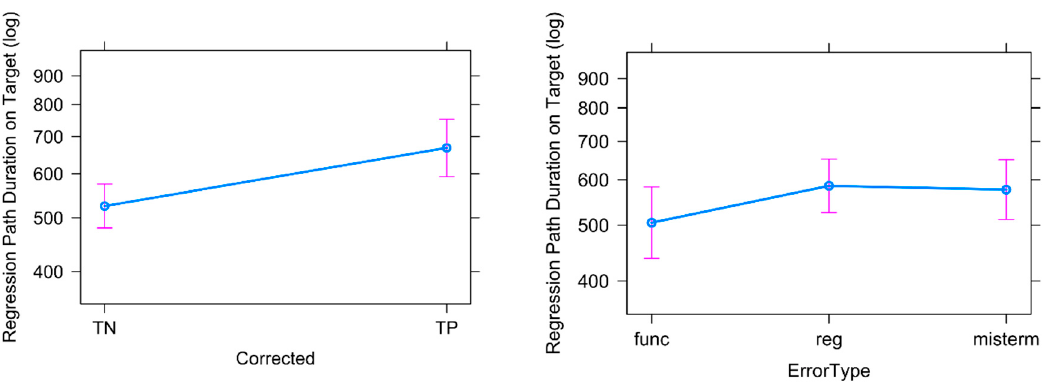
Figure 11. Effect of corrected ( left ) and error type ( right ) on regression path duration on target text.